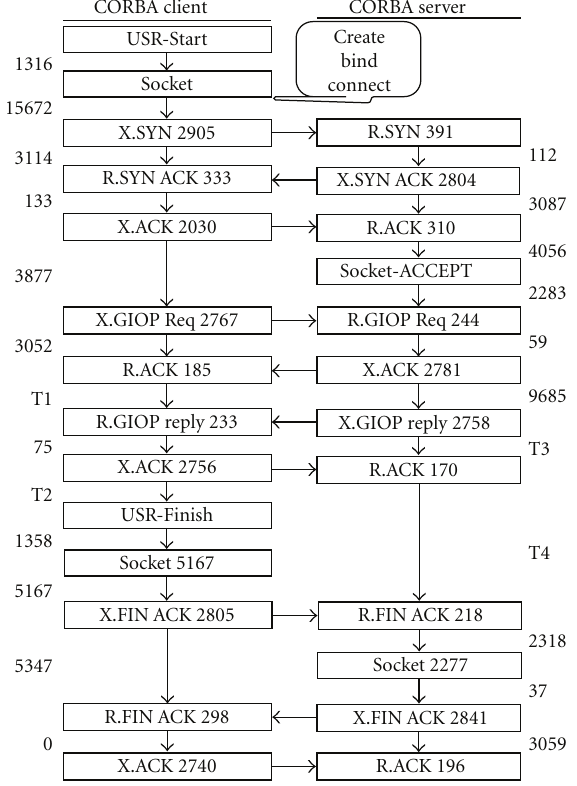
Figure 11: Measured latency values (in µ s) from CORBA IIOP transaction state diagram for software ORB.